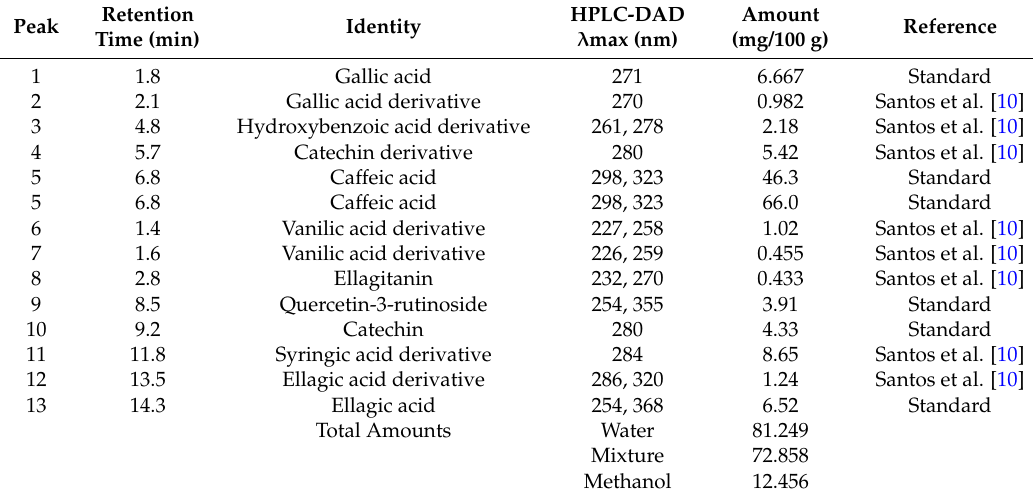
Figure 1. Representative high performance liquid chromatography with diode array detection (HPLC-DAD) chromatograms of the separation of phenolic compounds at 360 nm. ( A ) water extract of melon seeds, and ( B ) methanol–water extract of melon seeds. Table 1. Identification and quantification of phenolic compounds in honeydew melon seeds using reversed phase HPLC-DAD. Peaks 1–5 were identified in water extract and peaks 5–13 in water-methanol